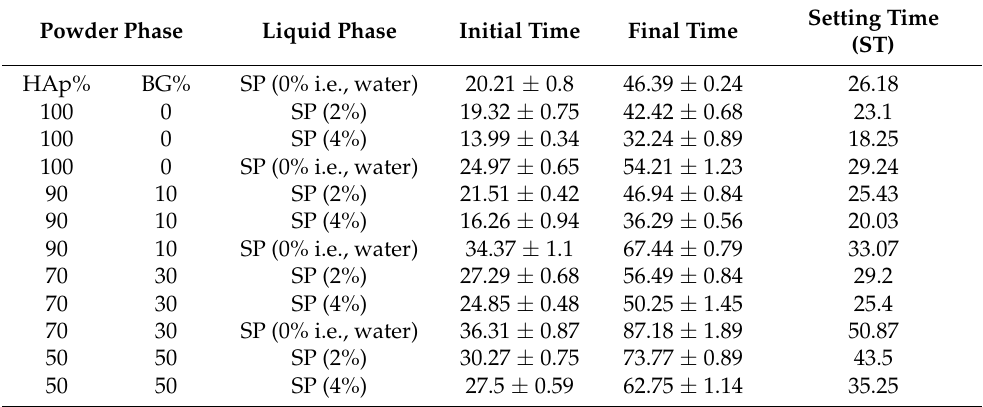
Table 4. Setting times of HAp and HAp/BG cements prepared using different weight ratios (the results were expressed as mean ± SD, n =